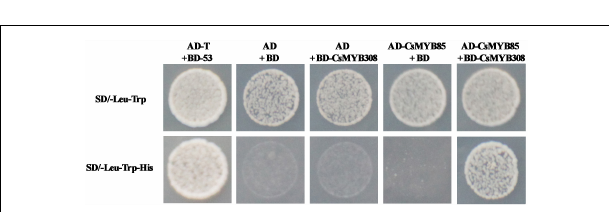
FIGURE 5 | Interaction between CsMYB85 and CsMYB308 determined using a yeast two-hybrid assay. Analyses of CsMYB85 and CsMYB308 interactions in yeast cells. The CsMYB85 and CsMYB308 coding regions were cloned into the AD and BD vectors, respectively. AD-T containing BD-53 and AD containing BD were used as positive and negative controls, respectively. Yeast clones were grown on SD media lacking –Leu/–Trp or –Leu/–Trp/–His for 3 days at 30 ◦ C. Results were obtained from three independent transformation